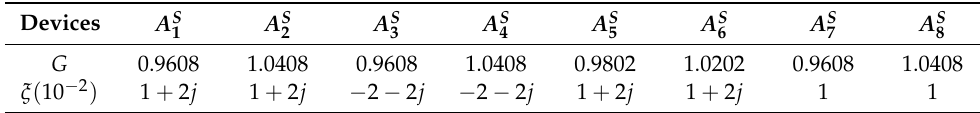
Table 2. The parameters of the simulated